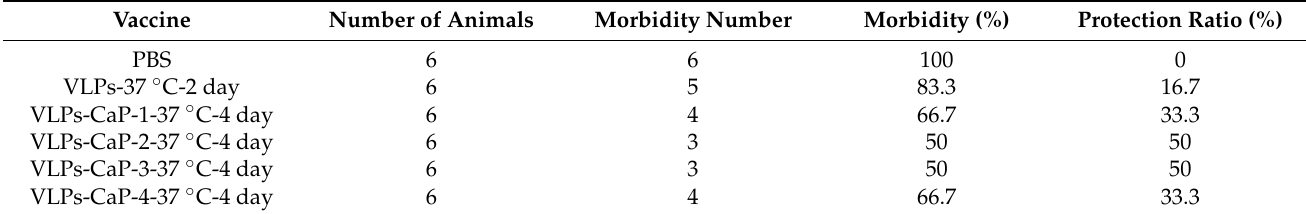
Table 3. Morbidity of guinea pigs immunized with different heat-treated